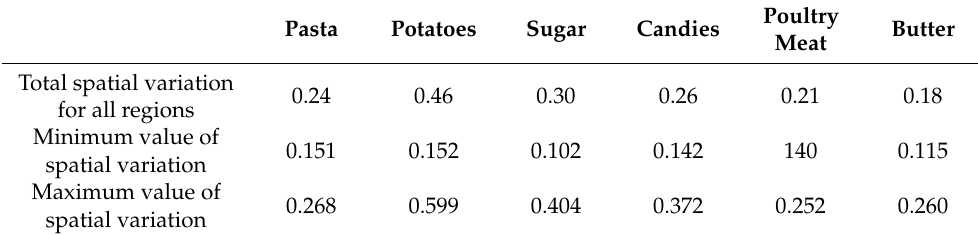
Table 2. Coefficient of variation, from 1 January 2019 to 31 March 2022.